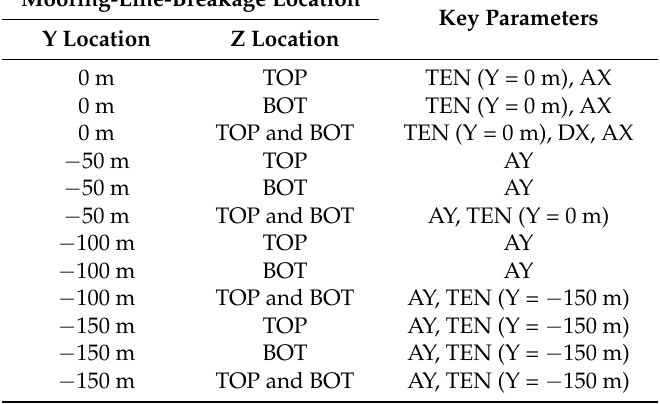
Table 4. Statistical data of mooring tension, surge motion of the location buoy, and acceleration of the net assembly in the X and Y directions in different mooring-line-breakage scenarios at H s = 1.0 m, T p = 6.0 s, and current velocity = 0.6 m/s (AVE = average value and STD = standard deviation).